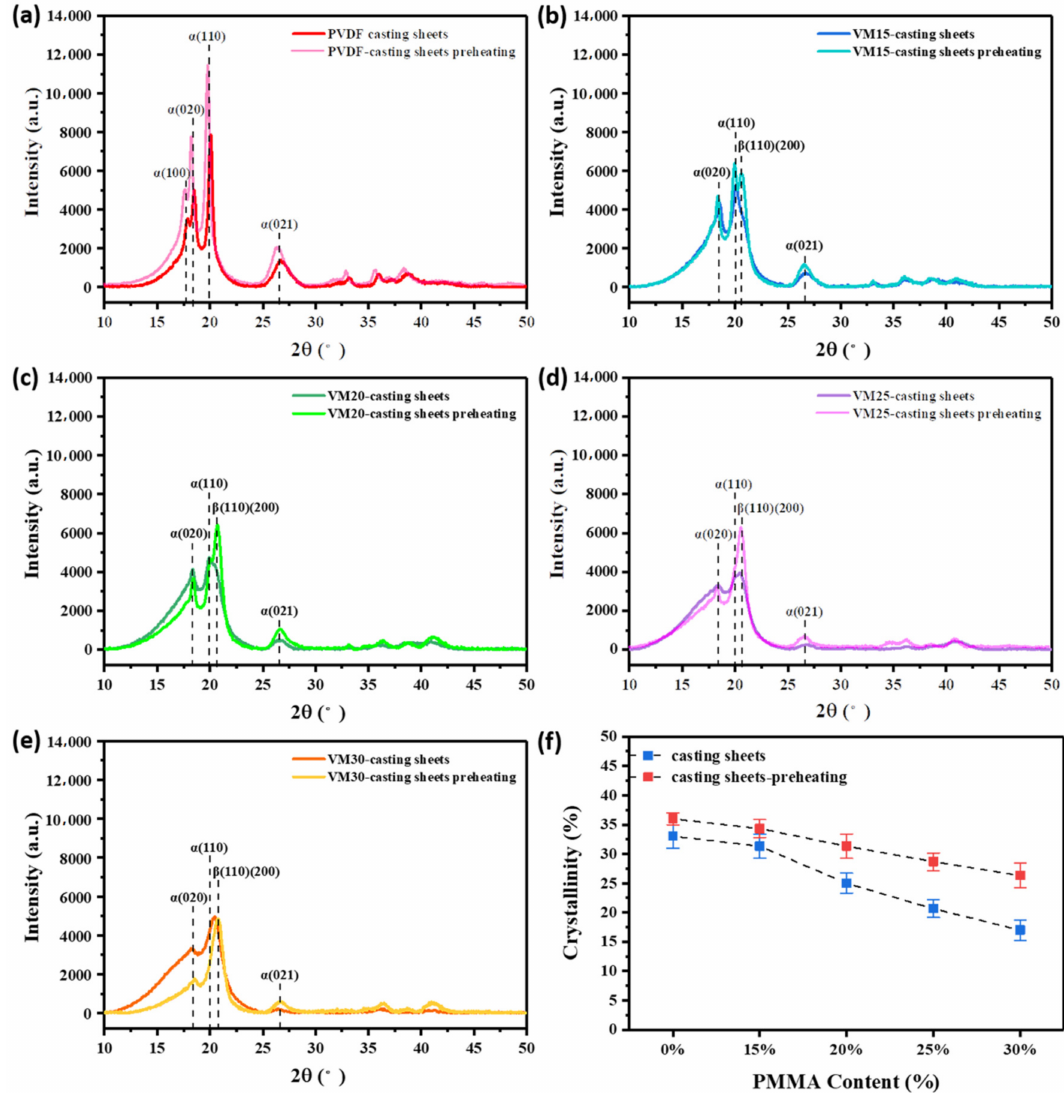
Figure 4. ( a – e ) XRD patterns of VM casting films before and after preheating; ( f ) Crystallinities of VM casting films before and after